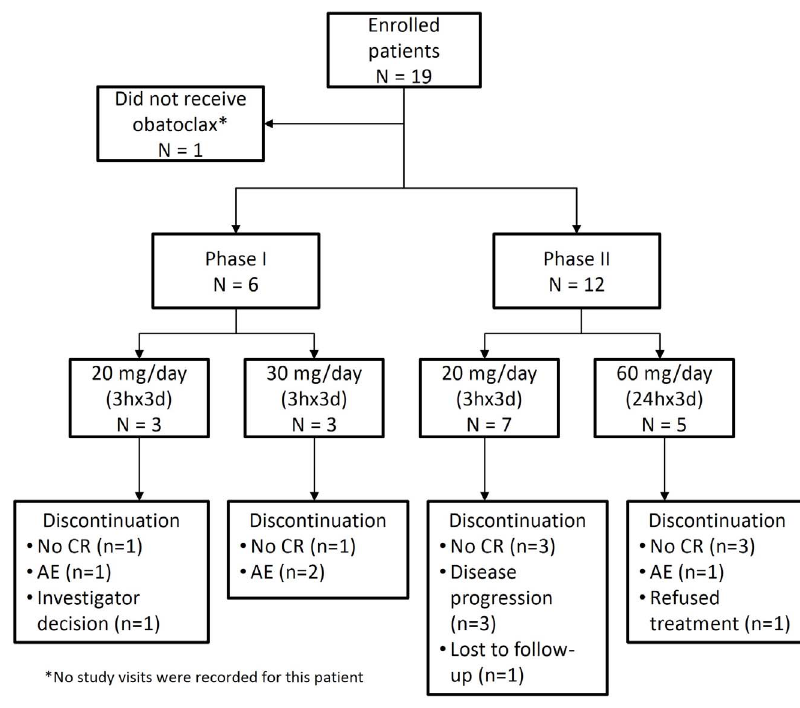
Figure 2. Patient disposition. AE, adverse event; CR, complete response.